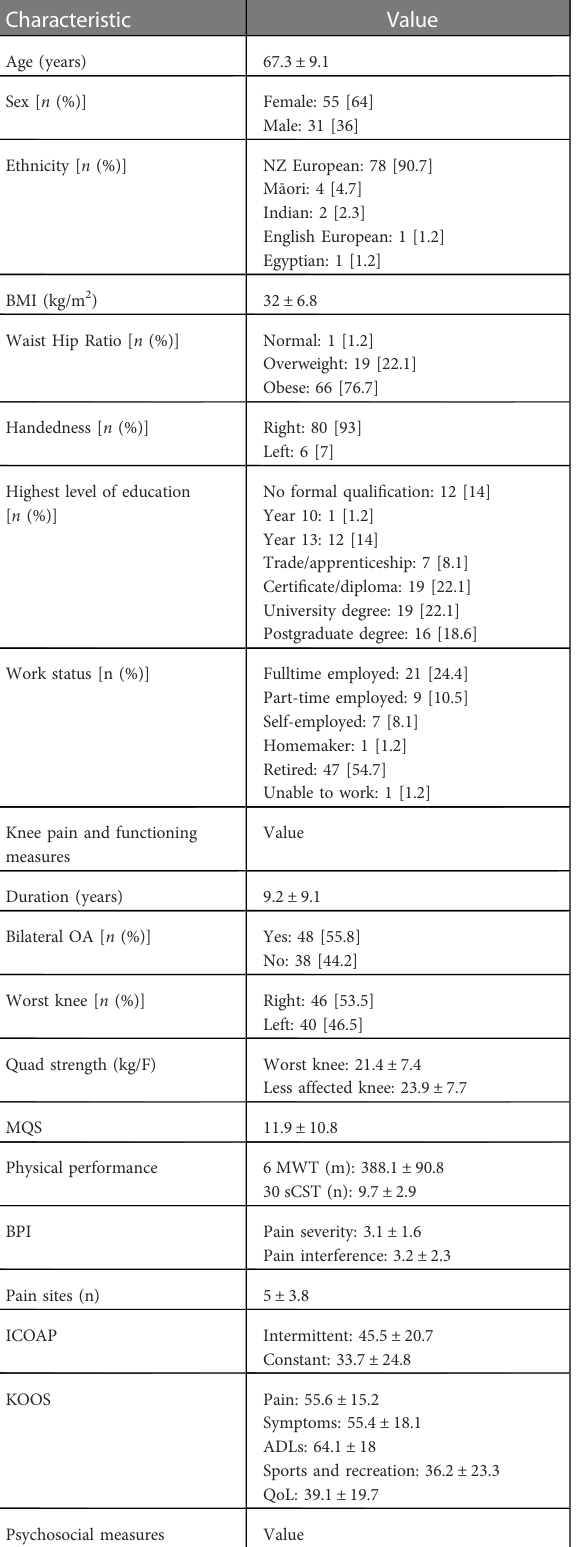
Characteristic Value